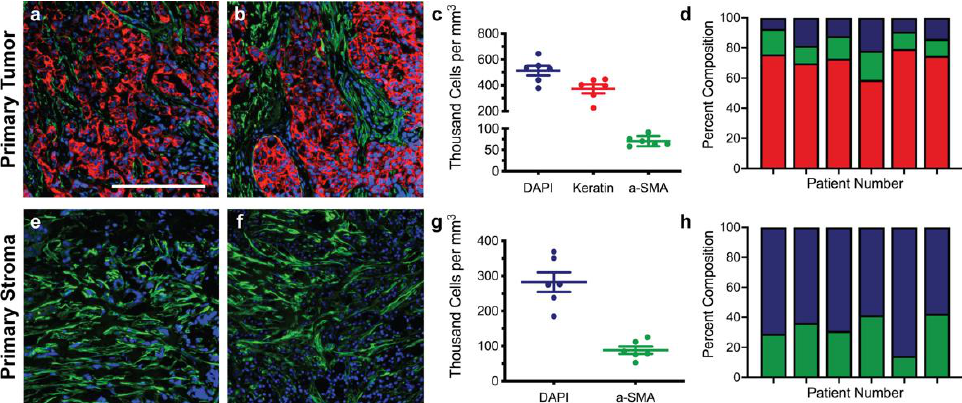
Figure 1. Staining and cellular quantification of primary breast cancer resections. Primary breast cancer patient resections were stained for breast cancer cells (anti-pan keratin; red), activated fibroblasts (anti- αSMA; green) , and total cells (DAPI; blue). The number of positively stained cells for each channel was counted in five random regions in order to determine the cell densities and percent compositions within the tumor ( a – d ) and within the stroma ( e – h ) for six patients ( n = 6). Scale bar = 200 μm.